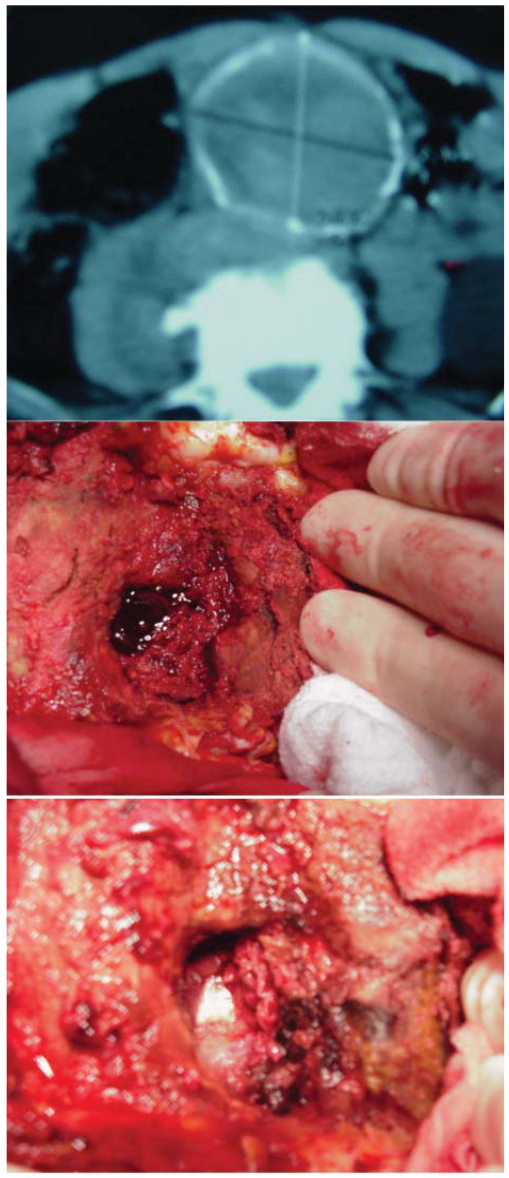
Figure 1 - Representative CT scan and intraoperative findings show a posterior rupture with hematoma (top), posterior rupture with hematoma (middle), and vertebral body exposure (bottom)